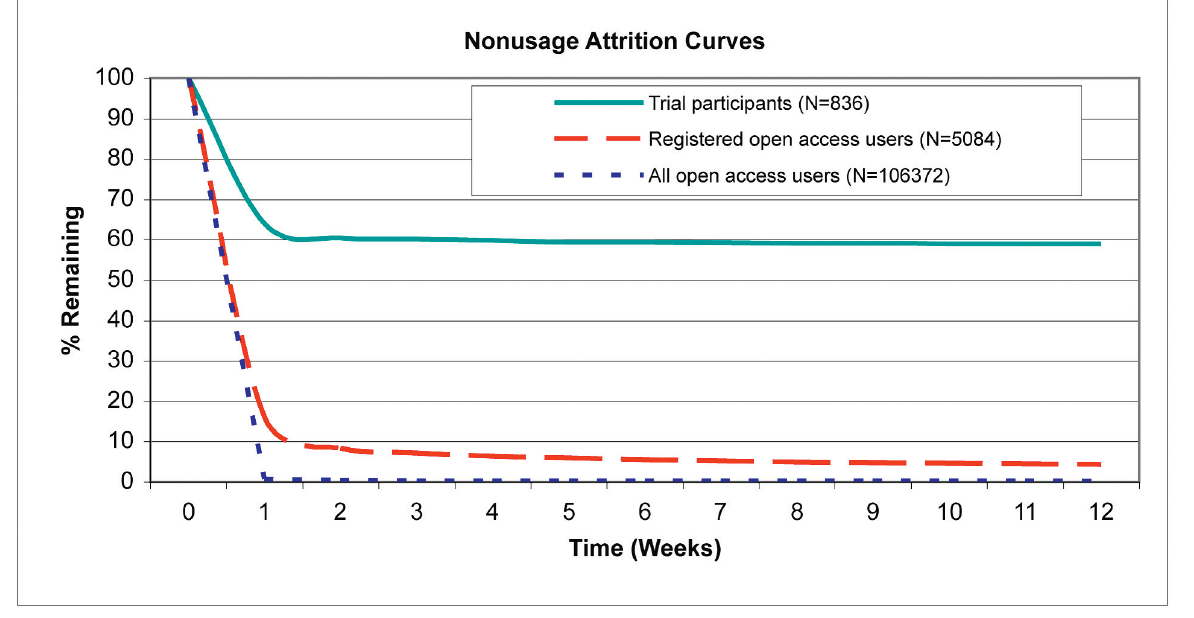
participants did not spend much time in the tailored modules during their first visit (Figure 6); however, the proportion spending more time in the tailored intervention was much higher for longest visits (Figure 7). In contrast, the curves are very similar for first and longest visits of open access users (all open access users and subgroup of registered open access users only), indicating that first and longest visits were identical.